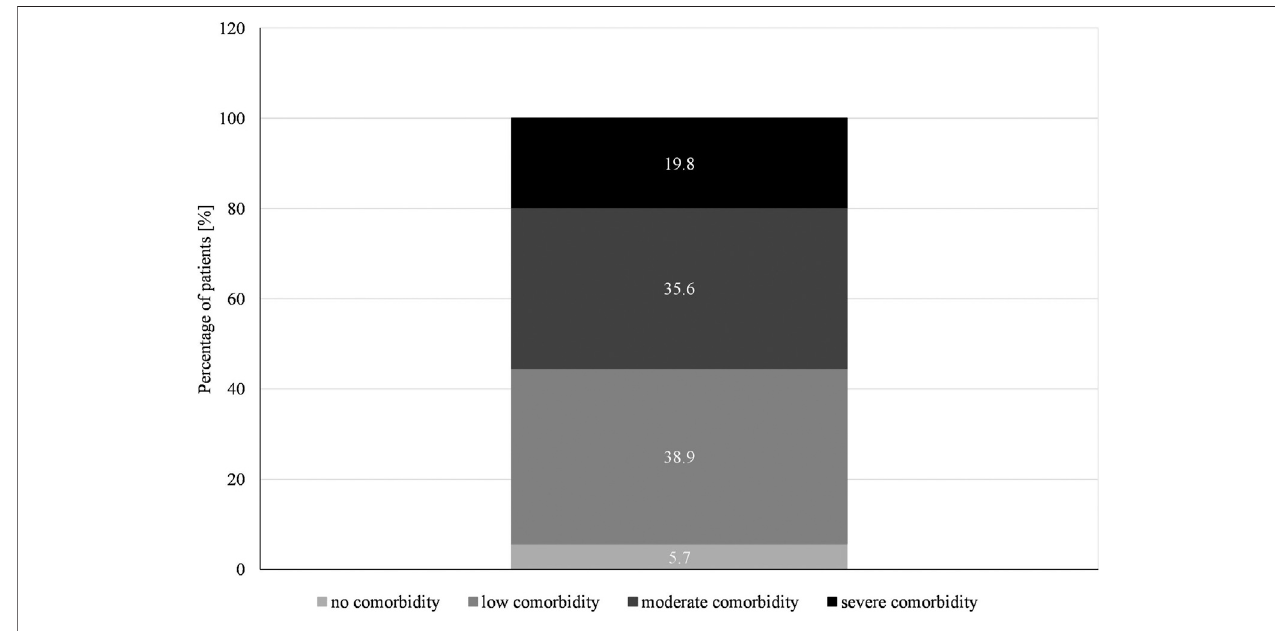
FIGURE 2 | Classi fi cation of comorbidities according to the Charlson-Comorbidity-Index ( N (cid:1) 334).